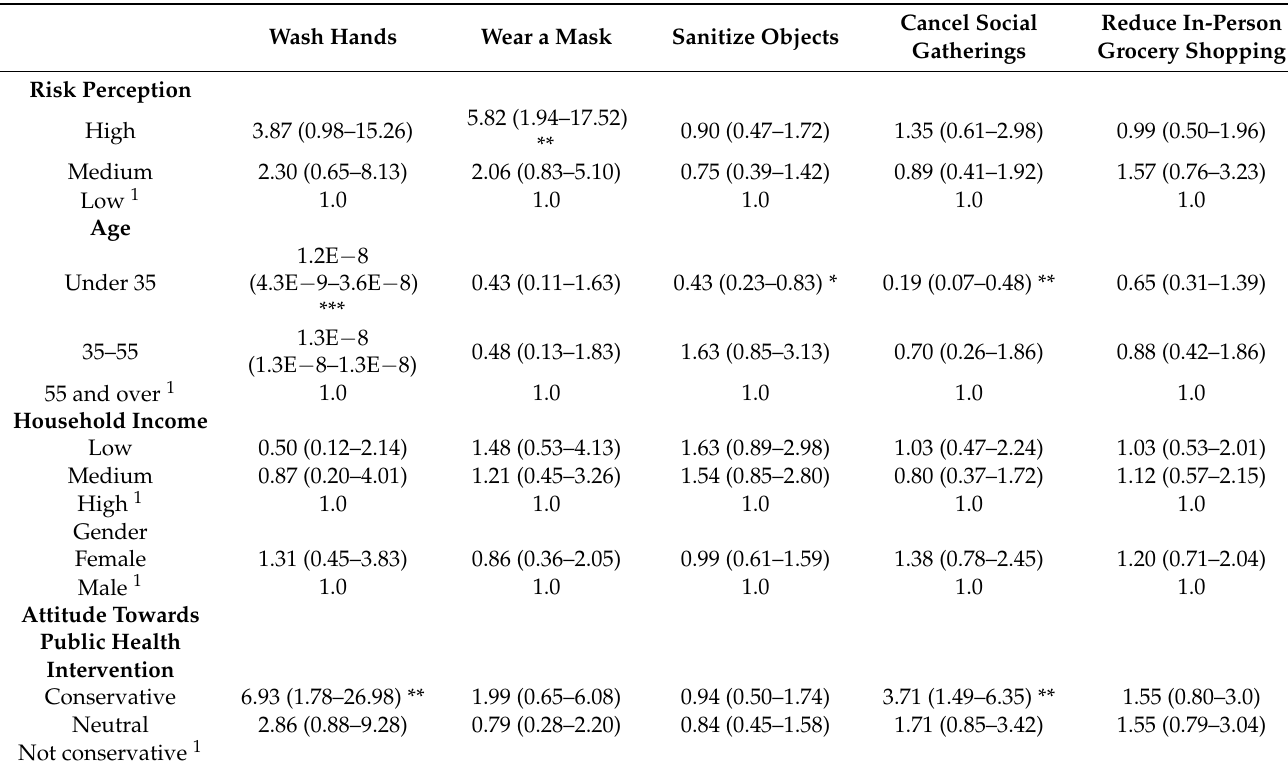
Table 5. Logistic regression analysis assessing factors associated with the level of prevention in June (reopening stage): odds ratio and 95% confidence